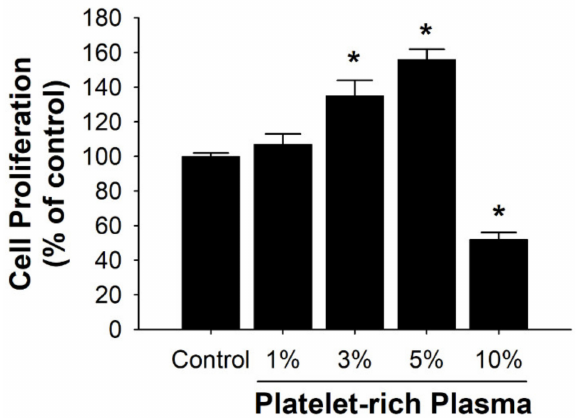
Figure 2. E ff ects in di ff erent concentrations of platelet-rich plasma (PRP) on cell proliferation of human fibroblast cells (HFCs) evaluated by MTT assays. Data are presented as the mean ± SD of three experiments performed in triplicate. * p < 0.05 contrasted to the control group.